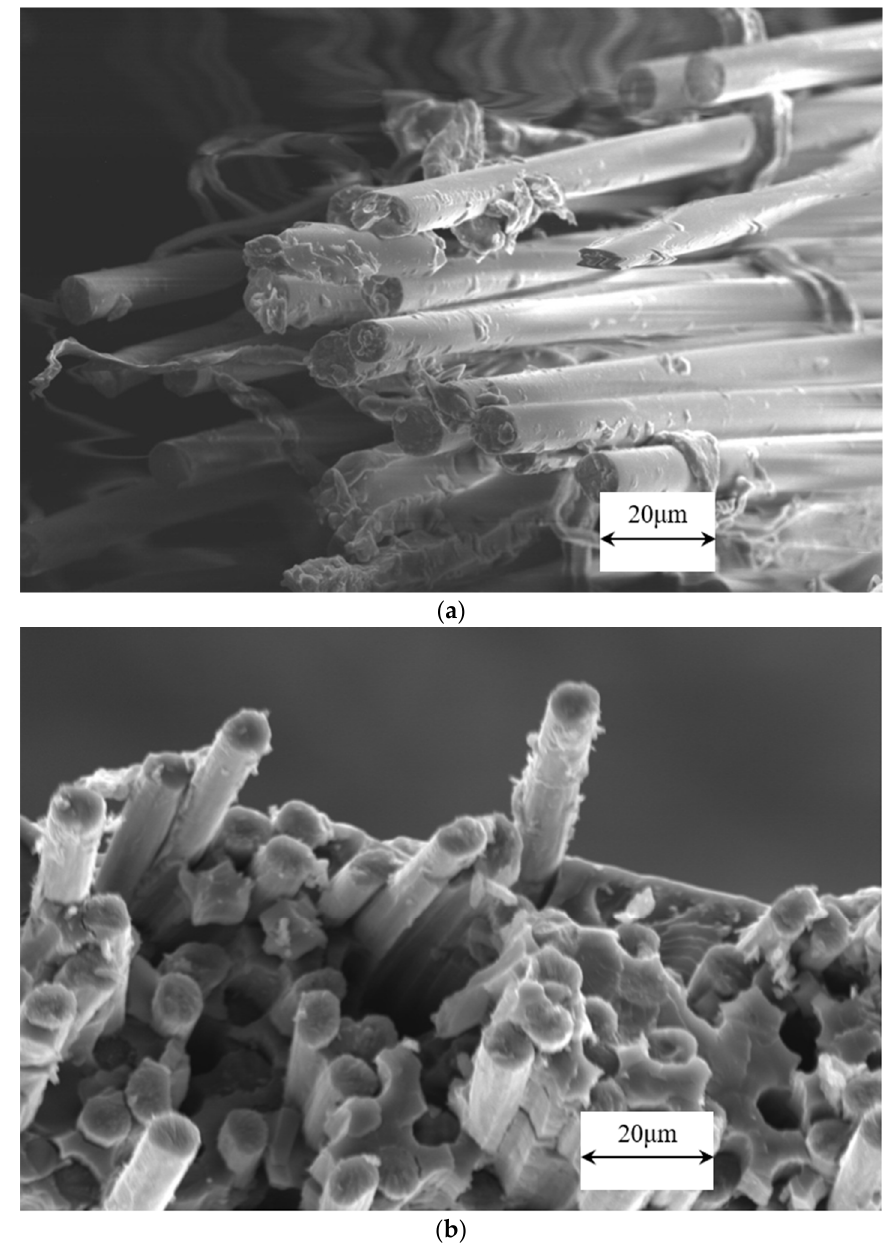
Figure 8. SEM images of fracture surface morphology of (a) C-GFRTP and (b) C-CFRTP.